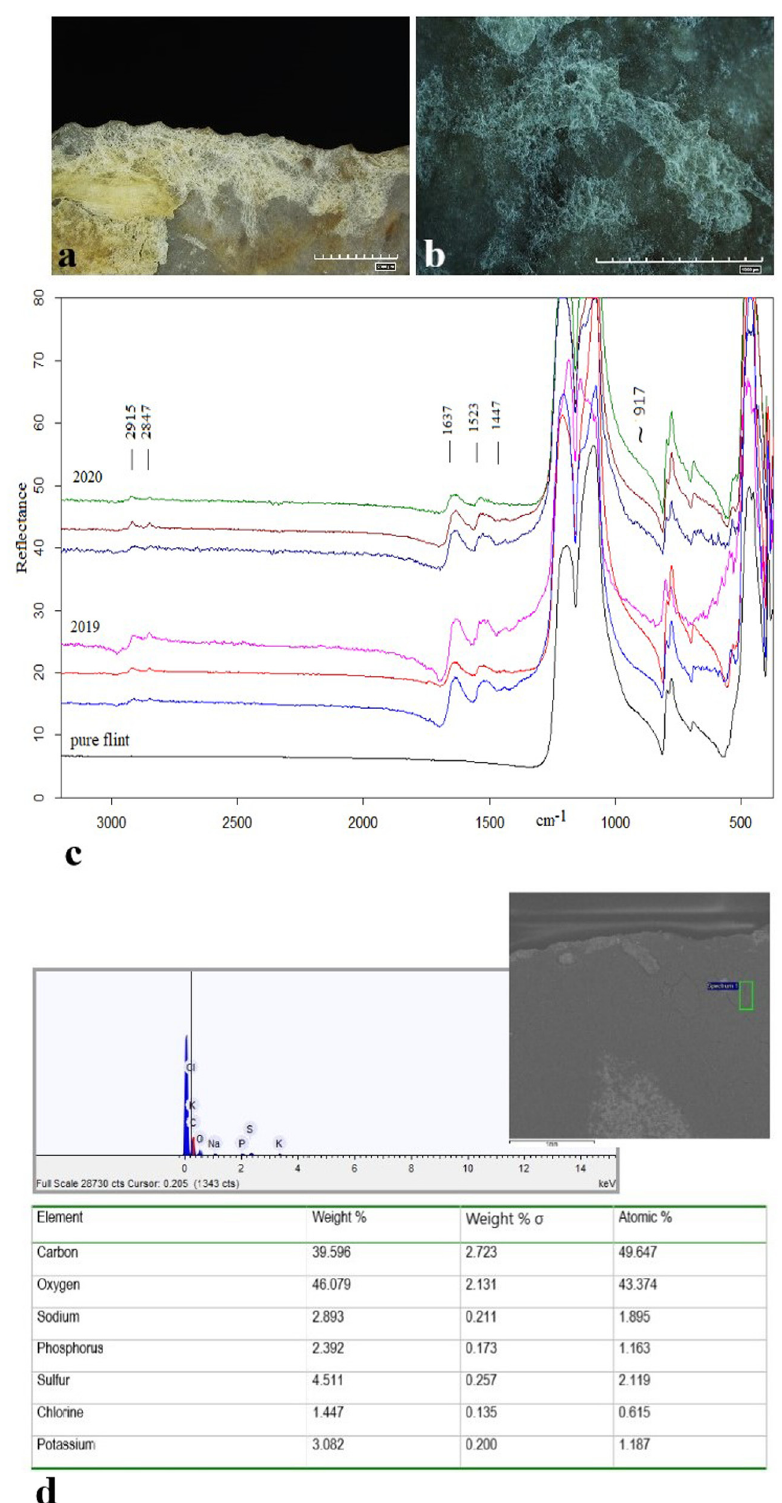
Figure 4: Residues left after scaling, both on the edge ( a ) and the surface area ( b ) , ( c ) FTIR analysis showing collagen, done 5 days after the experimentation ( March 2019 ) , and the second analysis, done after 1.4 years ( July 2020 ) , spectra showing AMIDE I and II from collagen and bone ( 917 cm − 1 ) , and ( d ) SEM - EDX results, the fl ake used for scaling ( FTIR spectra S. Nunziante Cesaro, photo A. Petrovi ć )